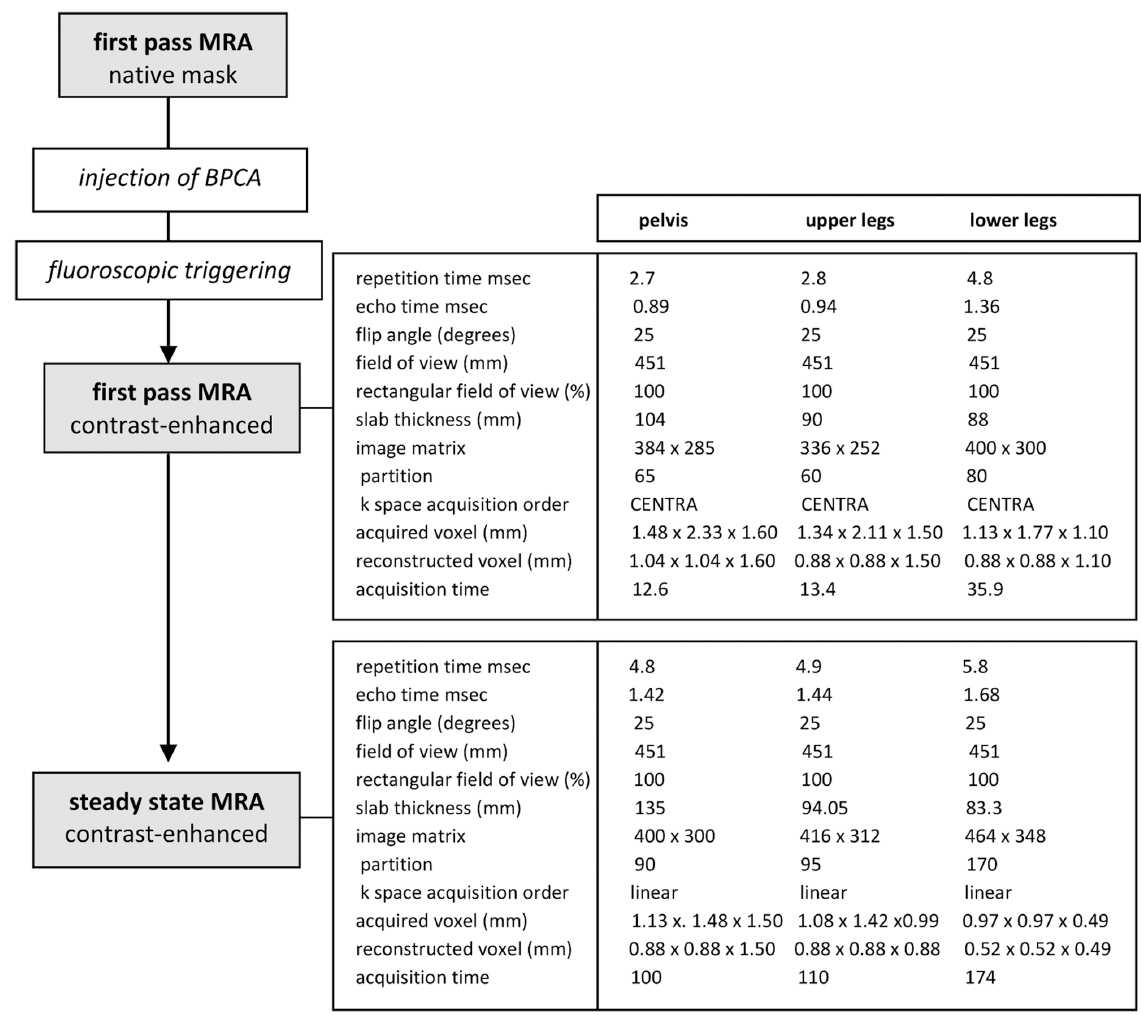
Figure 2. MR-angiographic protocol. Sequence flow of the combined first-pass and steady-state MR angiographic protocol and technical parameters of T1-weighted gradient-echo sequences for first-pass and steady-state MR angiography. doi:10.1371/journal.pone.0112340.g002 PLOS ONE |